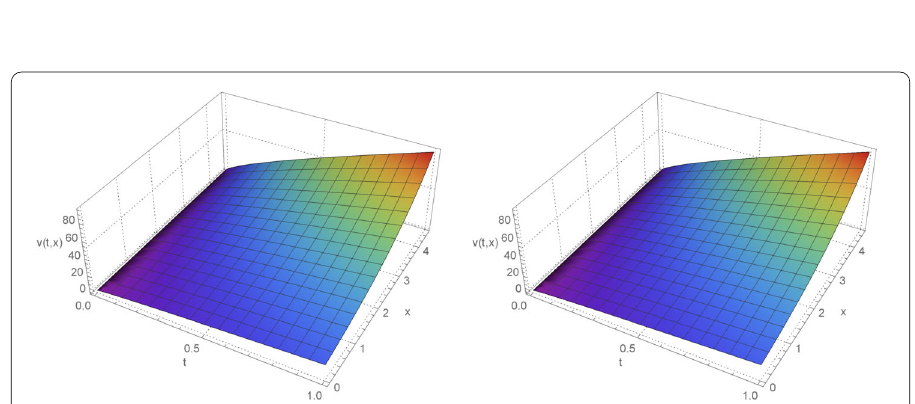
Figure 10 RPSM vs. q-HAM for Case II for V (2) ( t , x ) with β = 0.1, γ = 0.1 and α = 0.45